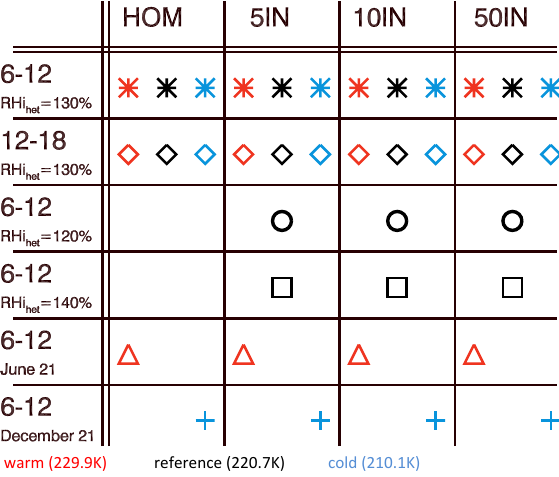
Figure 3. Summary of all 38 radiation calculations. Each sym- bol represents one radiation calculation. The horizontal shows how Fig. 3. Summary of all 38 radiation calculations. Each symbol represents one radiation calculation. many IN are included in the simulation from 0 in HOM to 50L − 1 On the horizontal it is shown how many IN are included in the simulation from 0 in HOM to 50 L − 1 in simulation 50 IN. The vertical shows the time of day simulated; in simulation 50IN. In the vertical the time period of the day which is simulated is shown whereas the the colour of each symbol shows for which temperature profile the colour of each symbol shows for which temperature profile the simulation is performed with blue for the cold ( T =210.1 K ), black for the reference ( T =220.7 K ) and red for the warm ( T =229.9 K ) profile. These simulation is performed, with blue for the cold ( T = 210 . 1K), black profiles can be found in Joos et al. (2009). Please note that the simulations with RHi het =120 % ,140 % for the reference ( T = 220 . 7K) and red for the warm ( T = 229 . 9K) are only performed from 6-12 local time and for the reference temperature profile only (black colour of profile. These profiles can be found in Joos et al. (2009). Please note symbols). The simulation for 21 June (21 December) are only done for 6-12 local time and the warm that the simulations with RHi het = 120% and 140% are only per- (cold) temperature profile, respectively. The symbols used in the table equal the ones in the figures in formed from 06:00 to 12:00LT and for the reference temperature section 3.2. profile only (black symbols). The simulations for 21 June (21 De- cember) are only done for 06:00–12:00LT and the warm (cold) tem- perature profile. The symbols used in the table are the same as the ones in the figures in Sect.